Question: Based on the figure, does the quantity rise or fall?
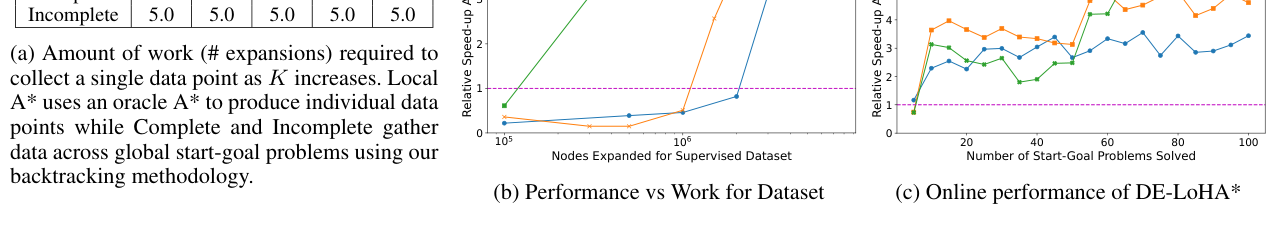
Answer: increasing